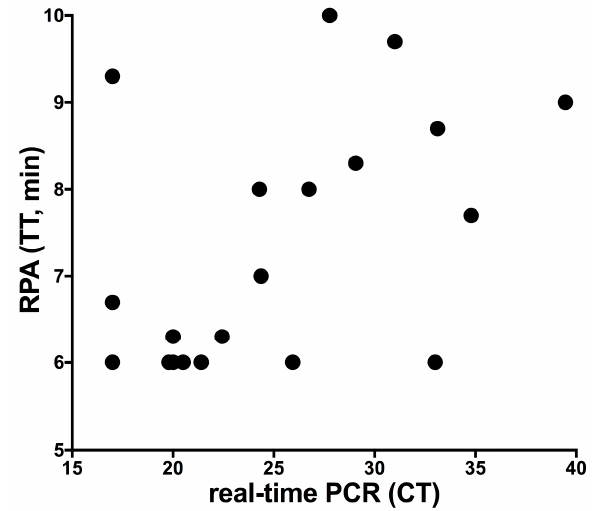
Figure 3. Results of clinical samples screened with both the MAP DNA SpeedXtract / MAP RPA protocol and the QIAamp DNA Blood Mini Kit / real-time Polymerase Chain Reaction (PCR) protocol. No correlation was found as the RPA assay was very fast, even with samples of high CT value. TT is threshold time; CT is cycle threshold.